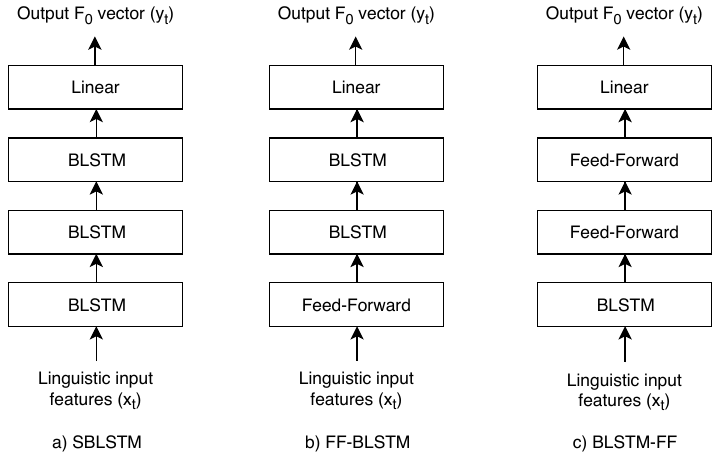
Figure 4. Model architecture. ( a ) Stack bi-directional long-short term memory (SBLSTM). ( b ) FF-BLSTM: Feedforward followed by bidirectional LSTM (BLSTM). ( c ) LSTM-FF: BLSTM followed by feedforward.